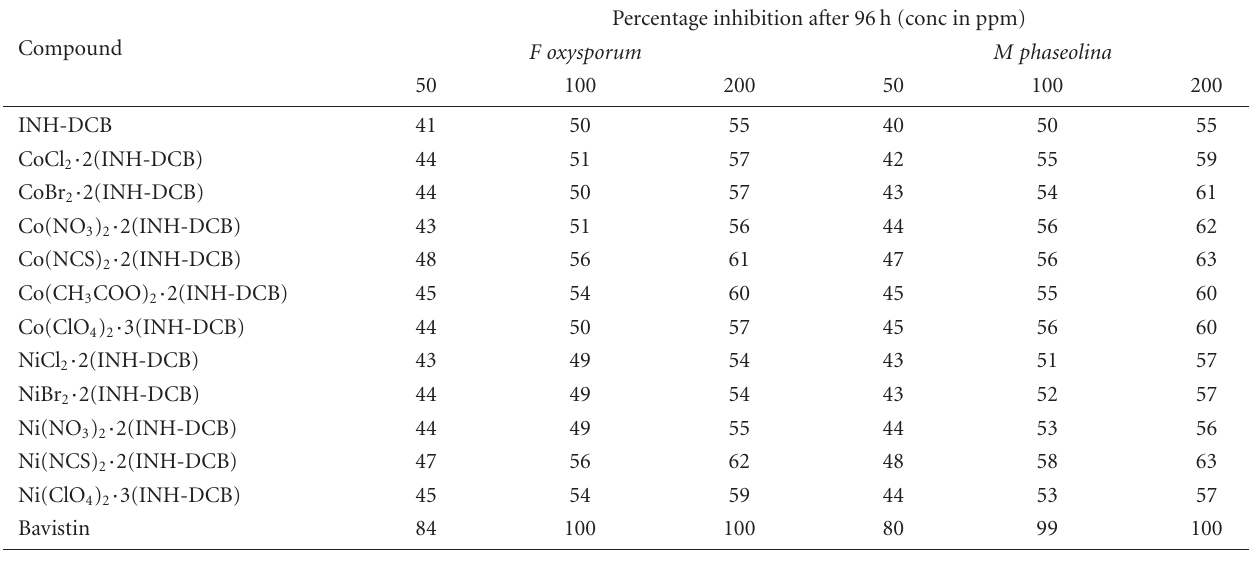
by measuring the diameter of colony after 96 hours and the